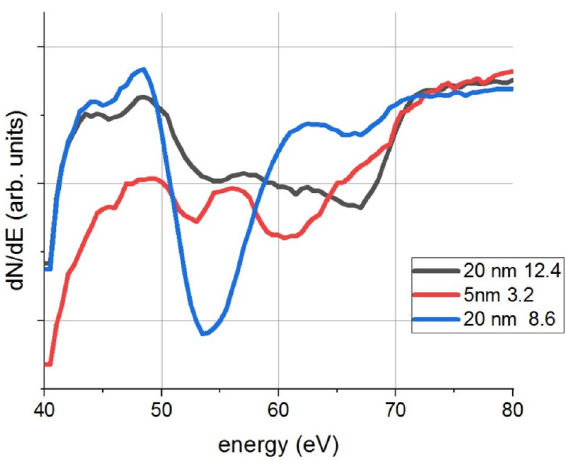
Figure 3. Al LLV lines in various depths (measured from the free surface) and samples (with 20 nm and 5 nm thick Al 2 O 3 layers, resp.); the last number in the legend gives the depth (in nm, measured from the free surface) of the region providing the Auger